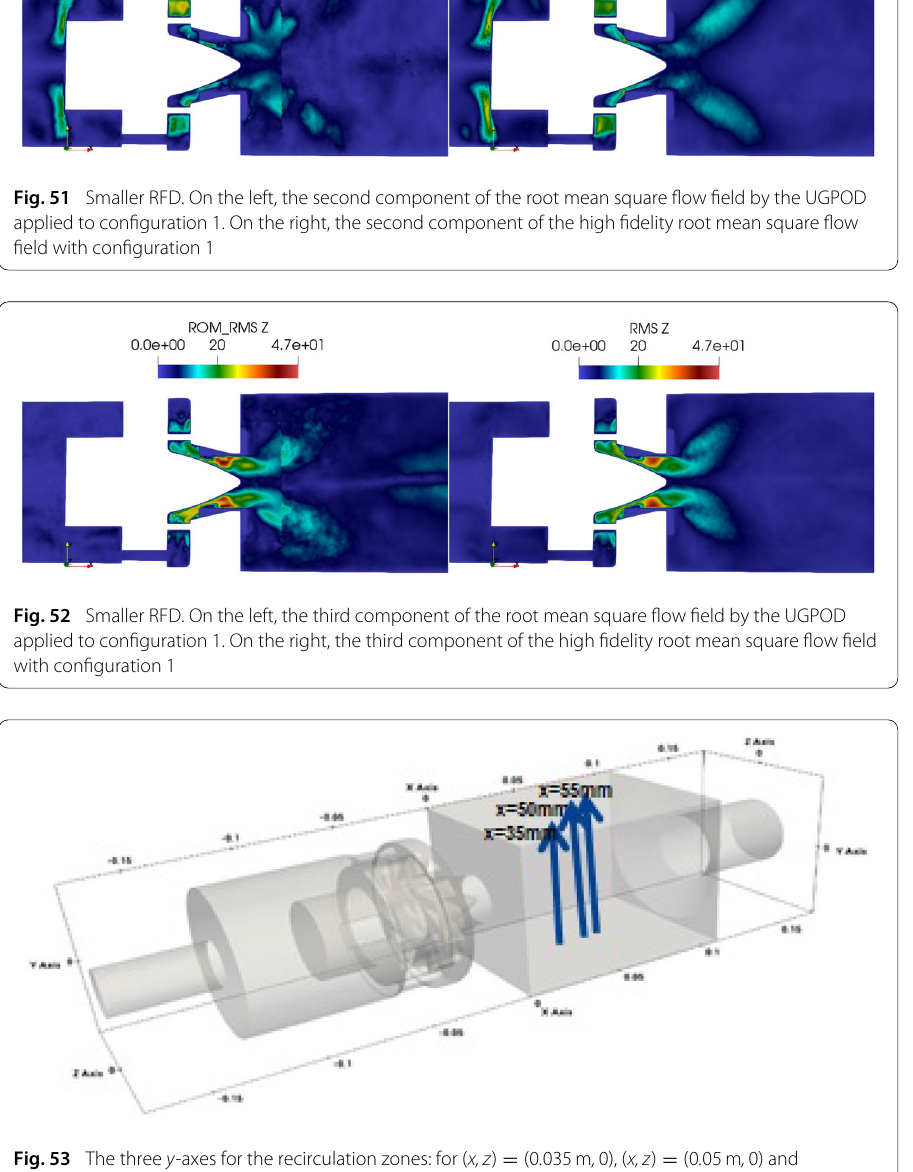
Fig. 53 The three y -axes for the recirculation zones: for ( x,z ) = (0 . 035m , 0), ( x,z ) = (0 . 05m , 0) and ( x,z ) = (0 . 055m ,